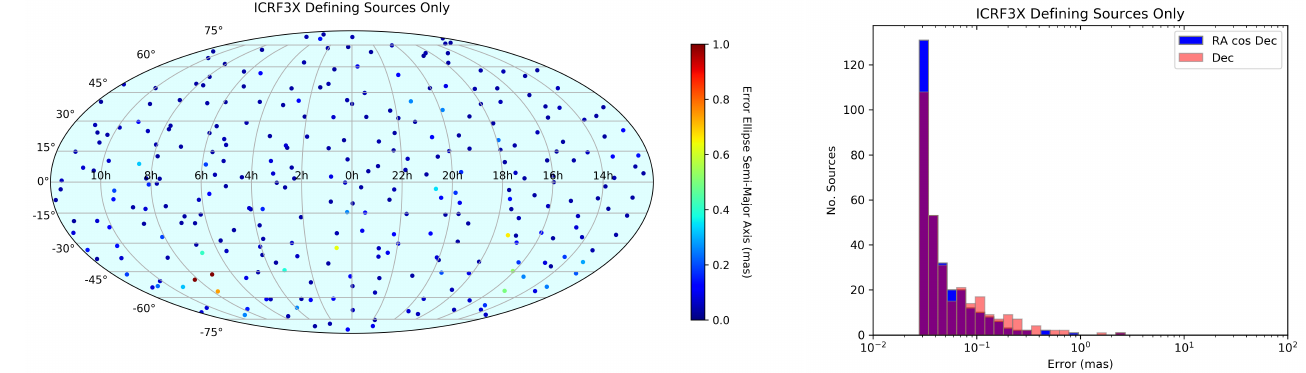
Figure 3. Left: Sky distribution of the 303 ICRF-3 defining sources. Each source is plotted as a dot color-coded according to its position uncertainty (defined as the semi-major axis of the error ellipse derived from the right ascension and declination uncertainties and correlation coefficients between the coordinates). The color scale ranges from 0 to 1 mas. Right: Distribution of coordinate uncertainties for these sources at S/X-band. Right ascension is shown in blue, declination in salmon, and the superimposed portion in purple. Reproduced from